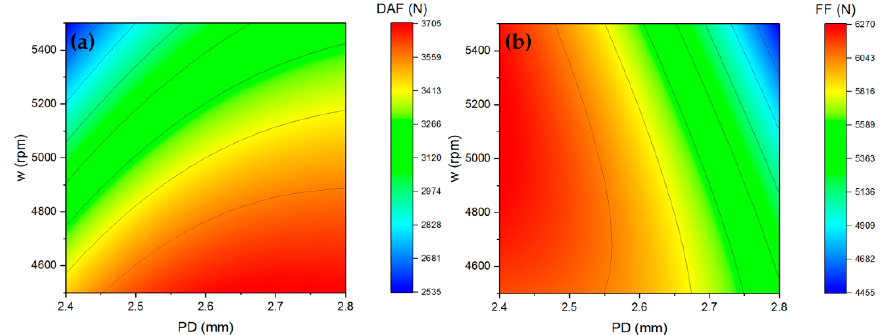
Figure 12. Contour plots of: ( a ) The downward axial force during the RAFSW process; ( b ) Failure force at a tensile shear test versus tool plunge depth ( PD ) and welding rotational speed ( w ) while other geometry and process parameters are the same as parameters of sample No. 21 except for the plunge depth, which is the same as pin length. The contour plots were extracted from developed ANN models in this paper. Table 9. An efficient working window of the geometry and process parameters to make lap joints by RAFSW.